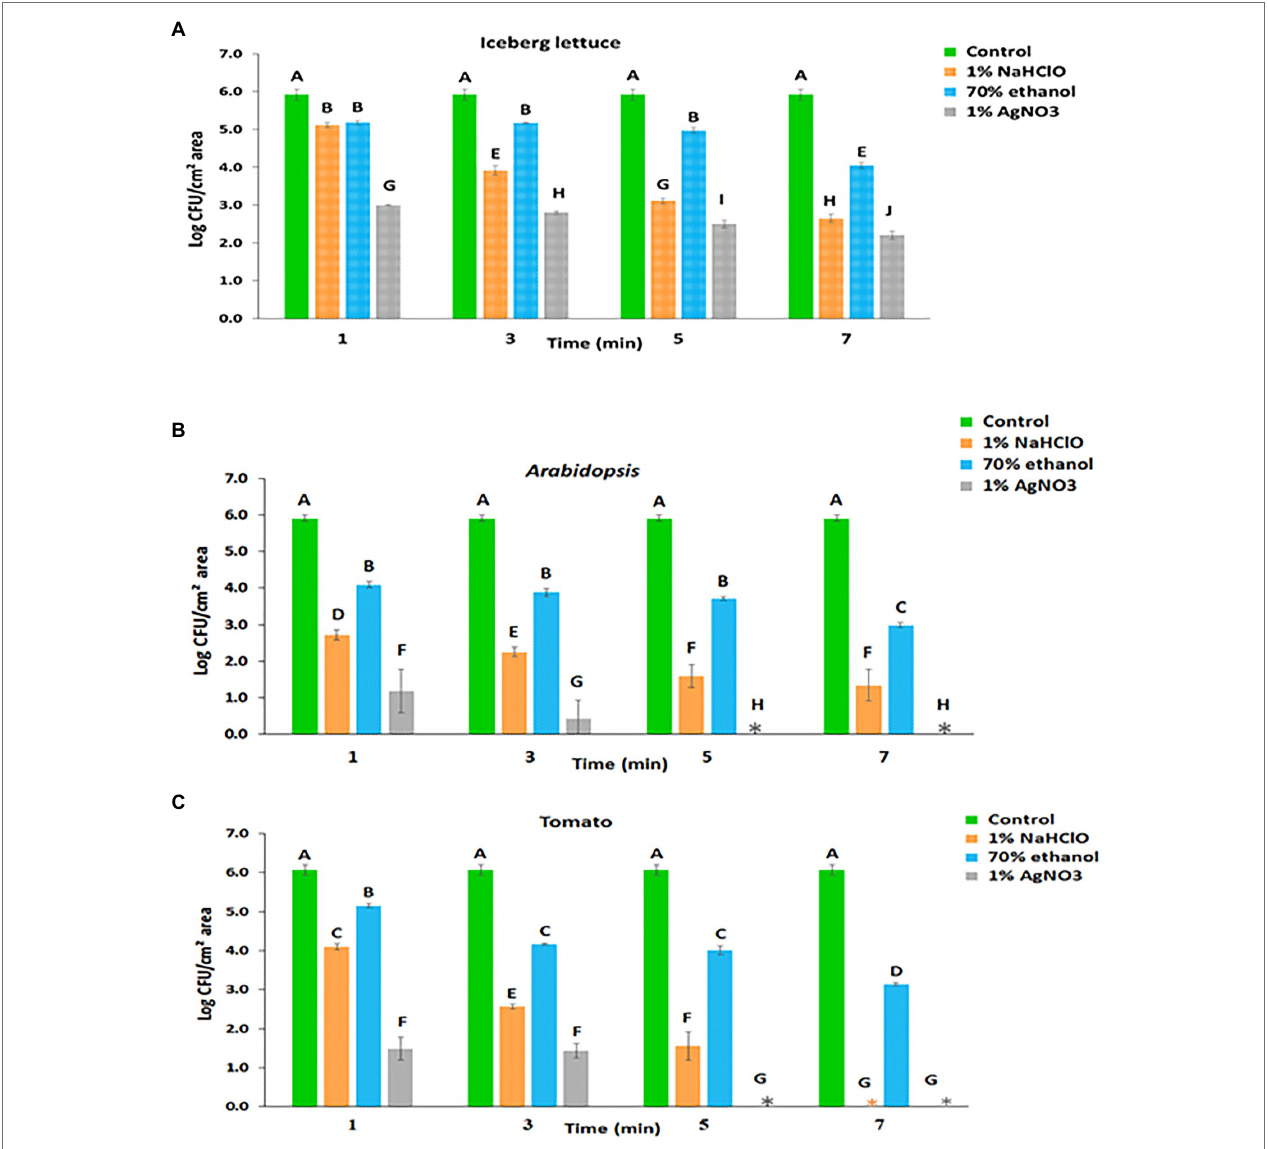
FIGURE 1 | Leaf internalization based on viable count following surface disinfection of (A) lettuce, (B) Arabidopsis , and (C) tomato. Mean and standard deviation values of two individual experiments each with three technical repeats are presented. Different letters indicate significant differences ( p < 0.05) in control and treated leaf samples, for a given plant, according to the Tukey-Kramer multiple comparison